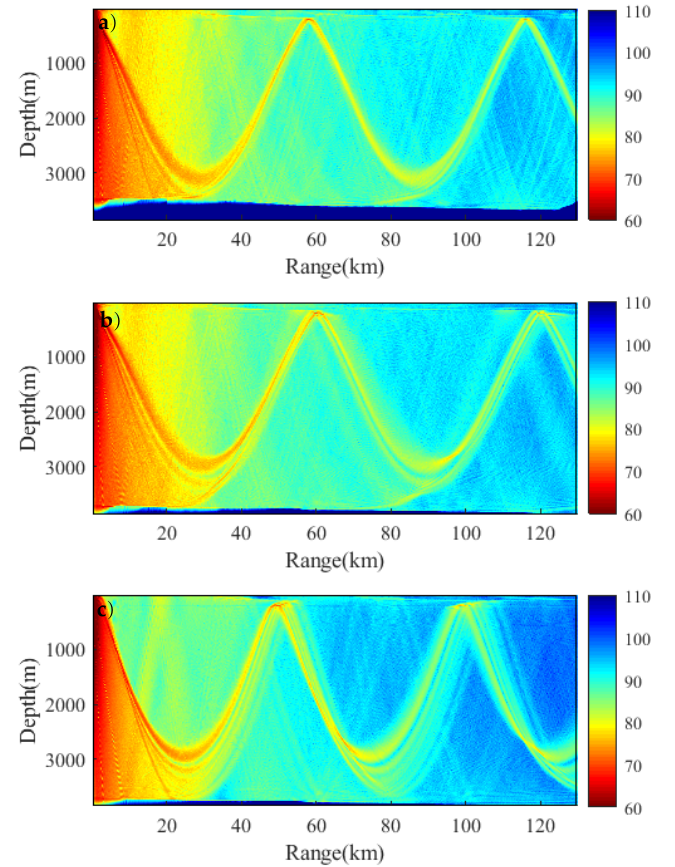
Figure 9. Two-dimensional TLs for the environments of the EIO 2019 ( a ), EIO 2021 ( b ), and SCS 2018 ( c ).